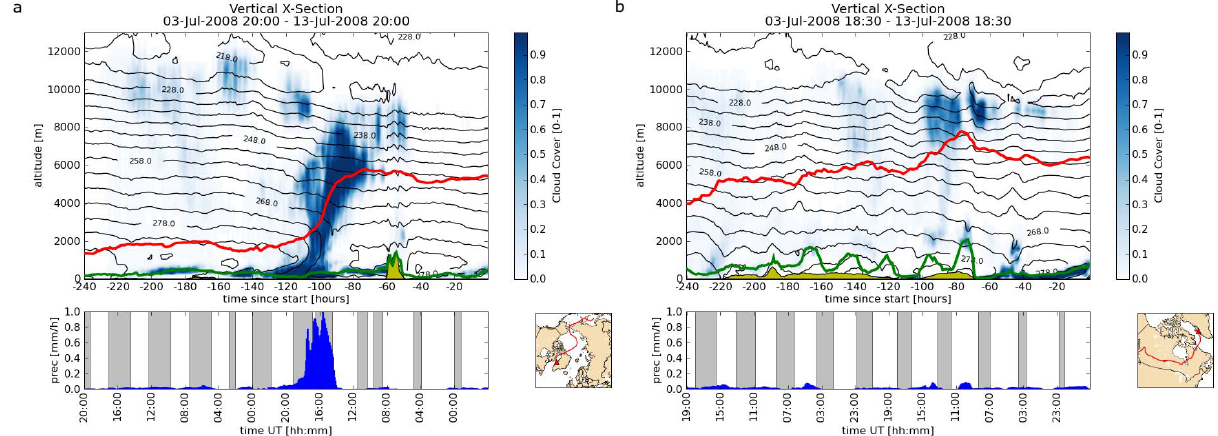
Fig. 8. Median values of the meteorological field data along the trajectories, released between 19:58:20–20:02:00 (a) and 18:26:40–18:28:24 (b) . Blue shades indicate cloud cover, black contour lines temperature, the green line the boundary layer height, the yellow pattern the orography as given by the ECMWF data, and the red line the median position of the trajectory ensemble. The lower panel shows median precipitation values at the surface (blue columns) and night times along the trajectory pathway (grey shade).